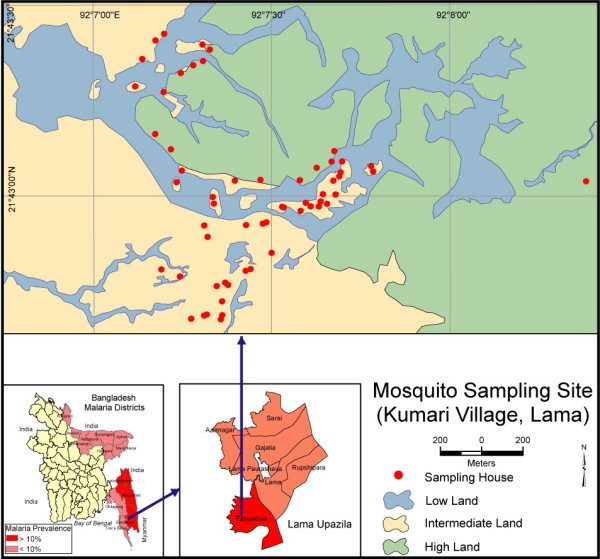
Sampling area in Kumari, Lama, Bangladesh. Low lands = rice field or water bodies, Intermediate lands = foothills, High lands = hilly forest.